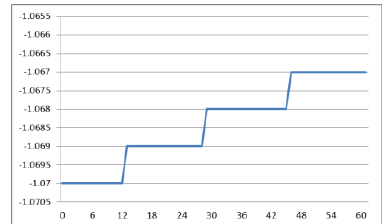
Figure 2. The angle between the solar orientation vector and the X axis of the sensor coordinate system during a period of time